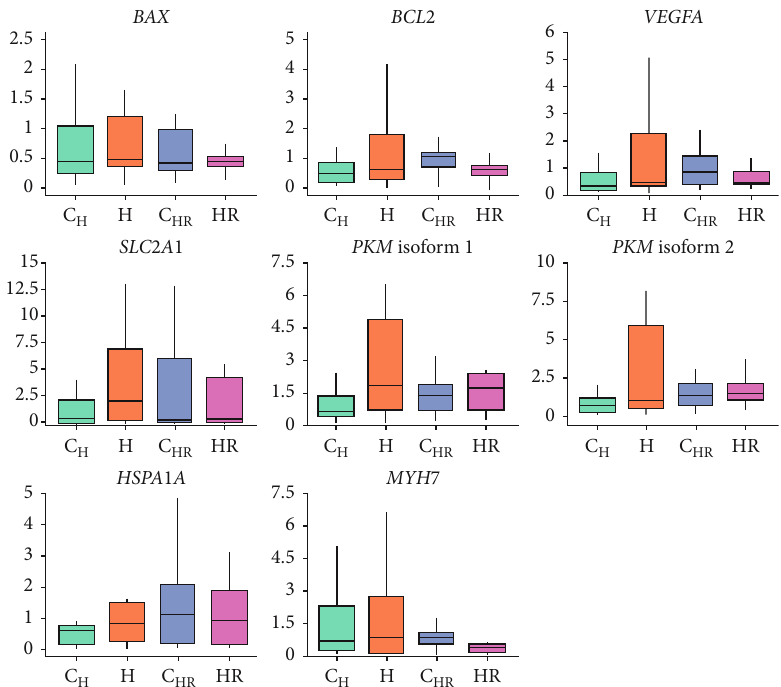
Figure 7: Gene expression of apoptosis-related BAX and BCL2, cellular stress-related HSPA1A and MYH7, angiogenic VEGFA and glycolysis-related SLC2A1, and PKM isoforms 1 and 2 in hiPSC-CMs after hypoxia (H: hypoxia; C : control for HR). There were signi fi cant intrasample and intercell line variation in the expression of the genes, and (HR: hypoxia; C HR the di ff erences in the expressions of the genes were subtle and not statistically signi fi